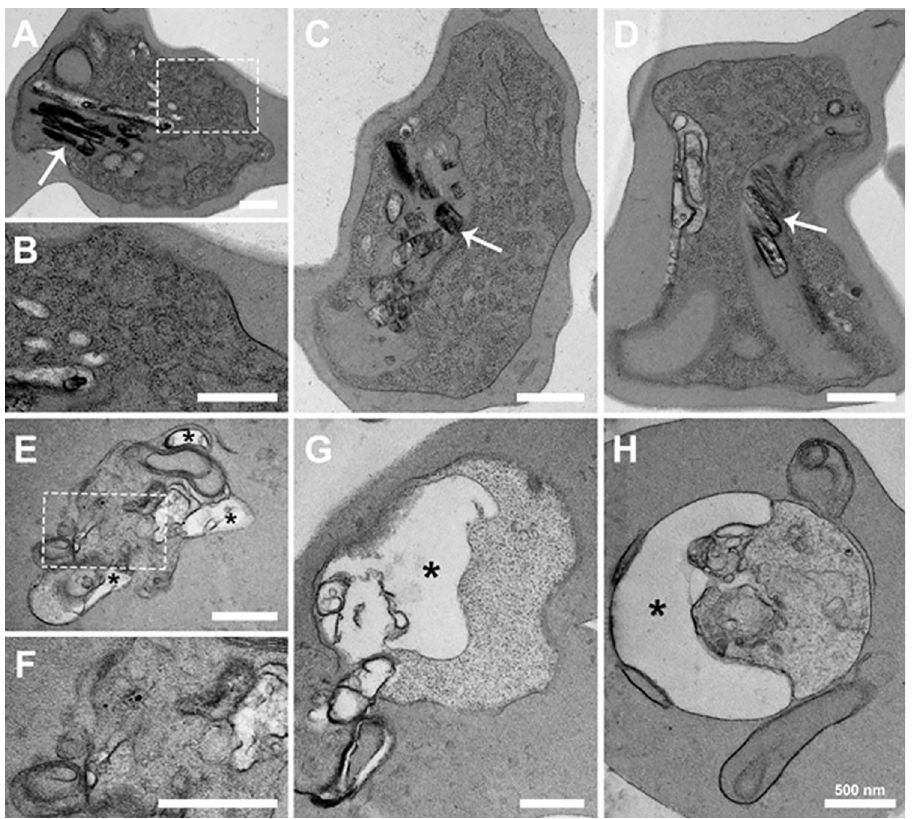
Fig 4. Treatment with 1,8-cineole induced ultrastructural changes in Plasmodium falciparum . Control cells (A–D) showed the characteristic structure of trophozoites, including an extensive endoplasmic reticulum network (A, white rectangle; B) and digestive vacuoles filled with hemozoin crystals (A, C, and D arrows). In contrast, cells incubated with 972 μ M 1,8-cineole showed loss of endomembrane integrity (E, white rectangle; F) and empty vacuoles resembling residual food vacuoles (E, G, and H,